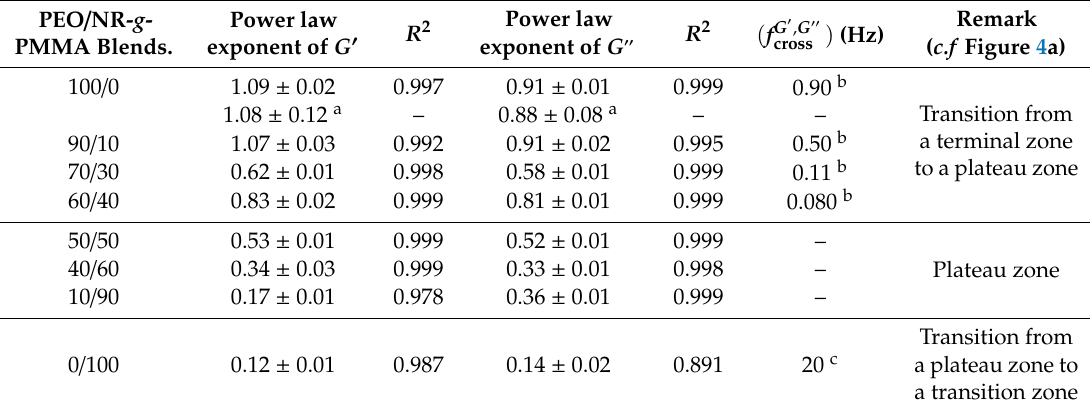
Table 2. Power law exponents of G (cid:48) and G (cid:48)(cid:48) for PEO / NR- g -PMMA blends at T = 140 ◦ C estimated with Equation (3). PEO / NR- g - PMMA